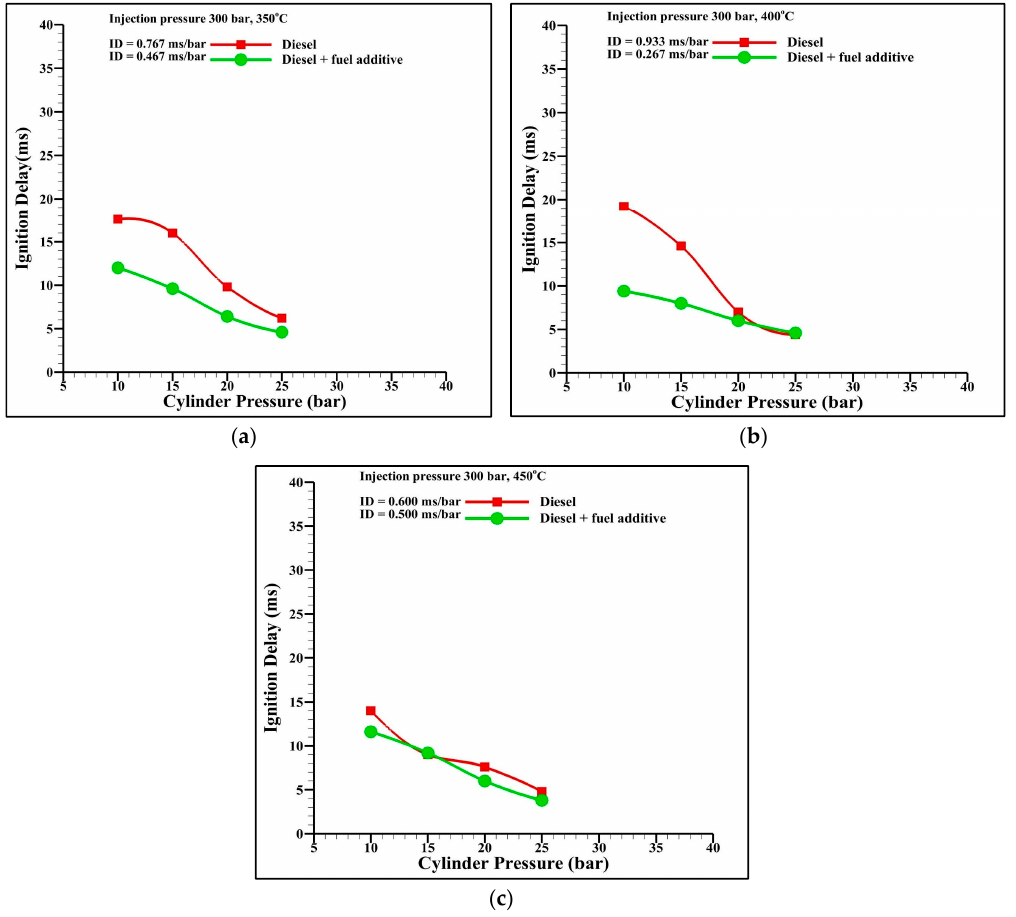
Figure 6. ID deviation of diesel and diesel with fuel additive at injection pressure 300 bar. ( a ) HST 350, Injection pressure 300; ( b ) HST 400, injection pressure 300; ( c ) HST 450, injection pressure 300.